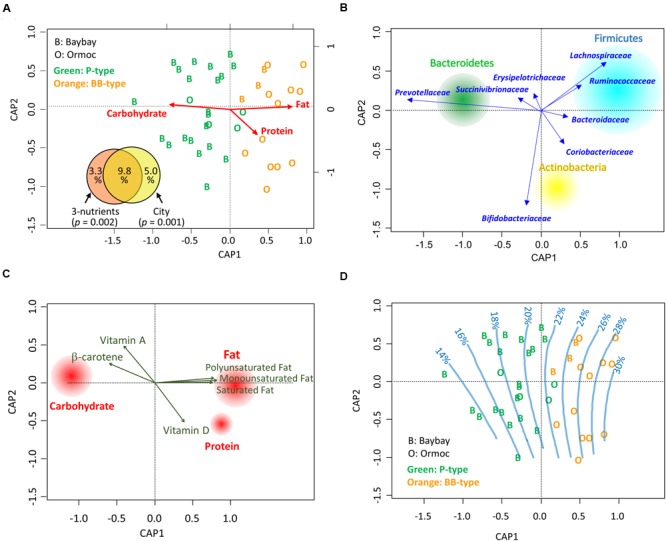
Correlation between dietary nutrients and gut bacterial communities in Leyte children. (A) Constrained analysis of principal coordinates (CAP) for the correlation between macronutrient intake and fecal bacterial composition. The individual datasets (n = 24 for Baybay, indicated by alphabet “B”; n = 16 for Ormoc, indicated by “O”) describing the energy ratios of macronutrient (carbohydrate, fat, and protein) intake were subjected to distance-based redundancy analysis (db-RDA) based on the Bray–Curtis distance between their family level bacterial communities. The alphabets representing the city of sample origin are colored according to the microbiota types classified in Figure 2B; “Green” and “Orange” letters indicate P-type and BB-type, respectively. The inset partition diagram explains bacterial community variance (adjusted R2) in terms of dietary macronutrients and/or city of residence, with p-values showing the significance of constraints calculated with 999 permutations. (B) Loading plot of bacterial phyla and families on the CAP ordination. The loadings of families were calculated by the db-RDA. The loadings of the three major phyla were calculated using envfit analysis to fit the phylum compositions of 40 samples to the CAP ordination. The size of each phylum circle represents total population size in the 40 Leyte samples. (C) Envfit plot of dietary nutrients on the CAP ordination. The daily intake level of each nutrient was correlated with sample variance in the CAP using envfit analysis; the nutrients showing significant correlation in 999 permutations (p < 0.05) were displayed by loading vectors. For macronutrients, their energy ratio data were subjected to envfit analysis and all three showed significance. The size of each macronutrient circle is proportional to R2 in the envfit analysis. (D) Gradient of dietary fat intake (energy %) on the CAP ordination. The fat energy intake ratio of the 40 Leyte children was fitted to the CAP coordinate by the ‘ordisurf’ function and regression splines are displayed.